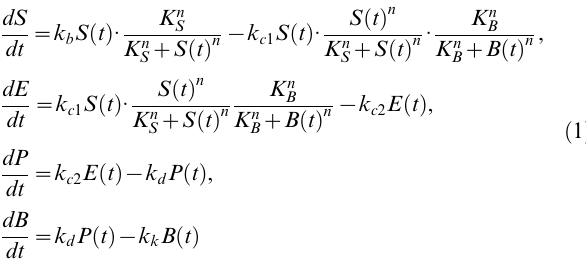
PLoS Computational Biology |